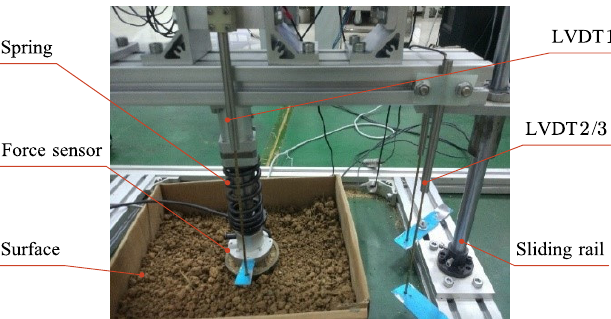
Figure 8. Experimental setup of the single robot leg.